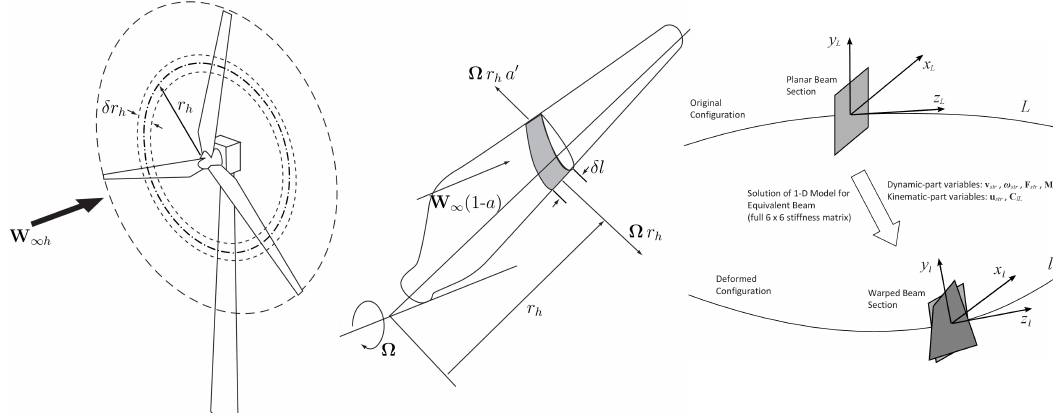
Figure 1. Schematic representing an annular actuator generated by a blade element (based on a representation from Burton et al. [20] for classical BEM). The rightmost Figure is a schematic representation of the GTBM technique along the reference line showing the coordinate system before and after deformation. Also indicated in that Figure are the variables in the dynamic and kinematic parts of the